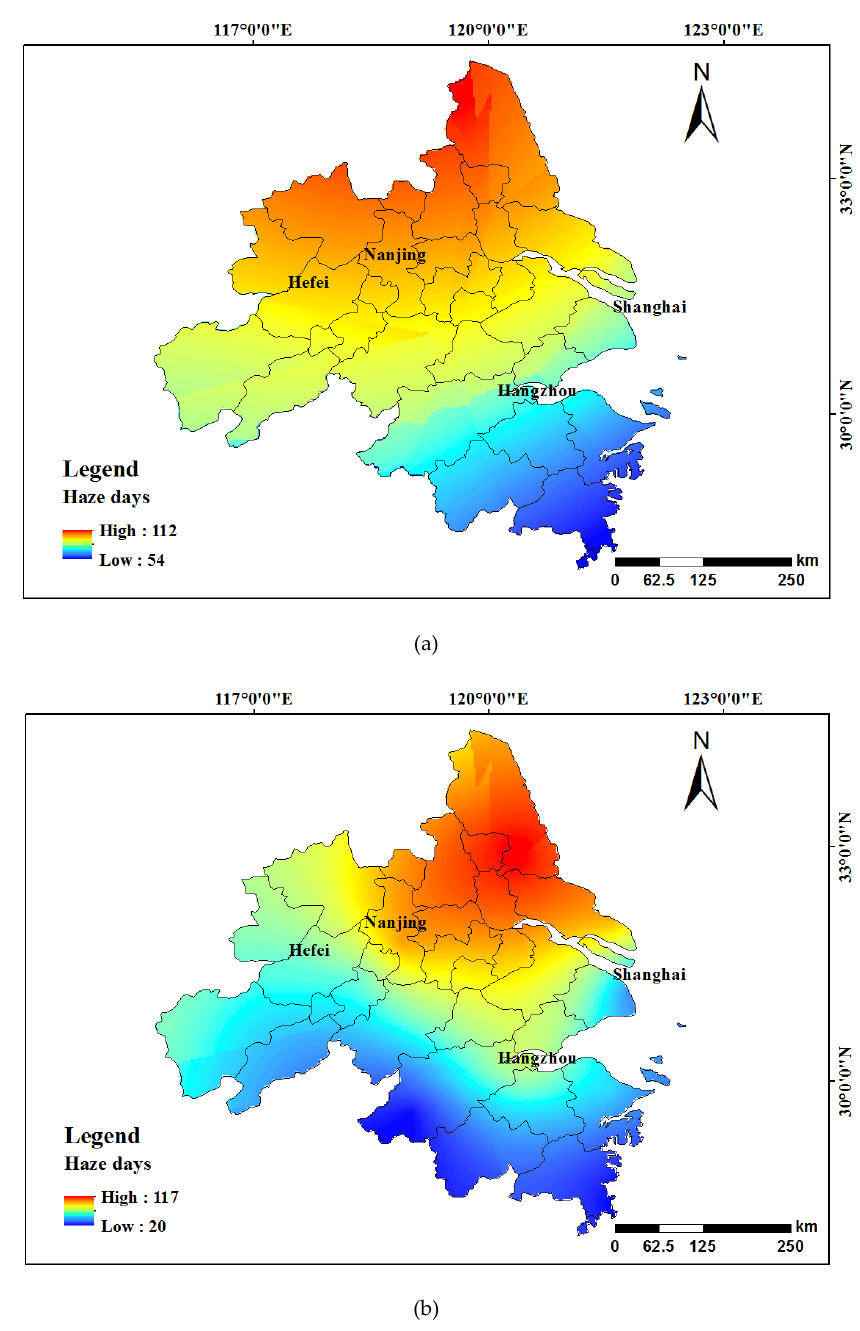
Figure 3. The spatial distribution of haze days in each meteorological station in the YRDUA from 2014 to 2017 during the dry season ( a ) and wet season ( b ).